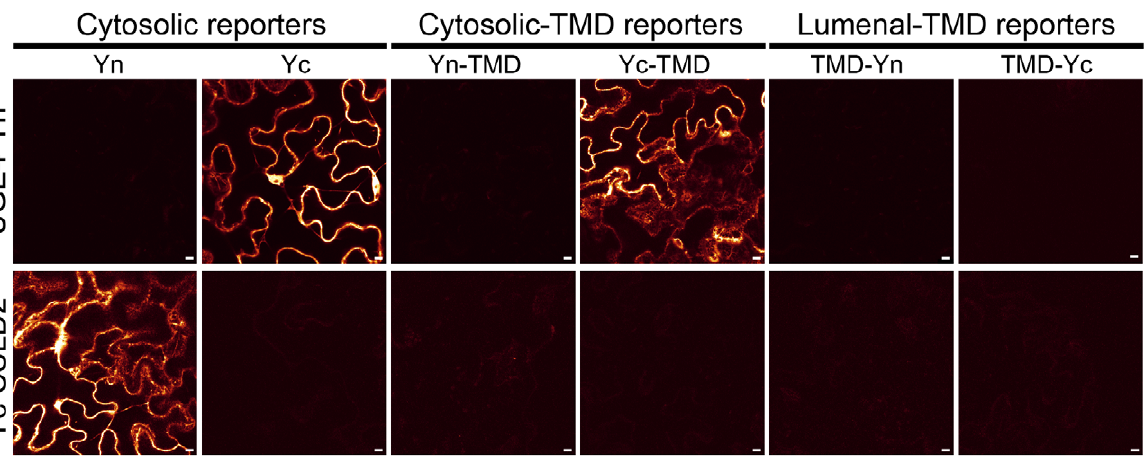
Figure 6. GO-PROMTO analysis of cytosolic (UGE4) and multimembrane spanning protein (CSLD2) known to be involved in cell wall polysaccharide biosynthesis in plant. UGE4 was fused to Yn at the C-terminus and CLSD2 was fused to Yc at the N-terminus and were transiently expressed in Nicotiana benthamiana . Observation was carried out by CLSM at 3 DPI. Scale bars, 10 m m. At least two individual experiments were performed for each combination with the similar results. Raw images are shown.